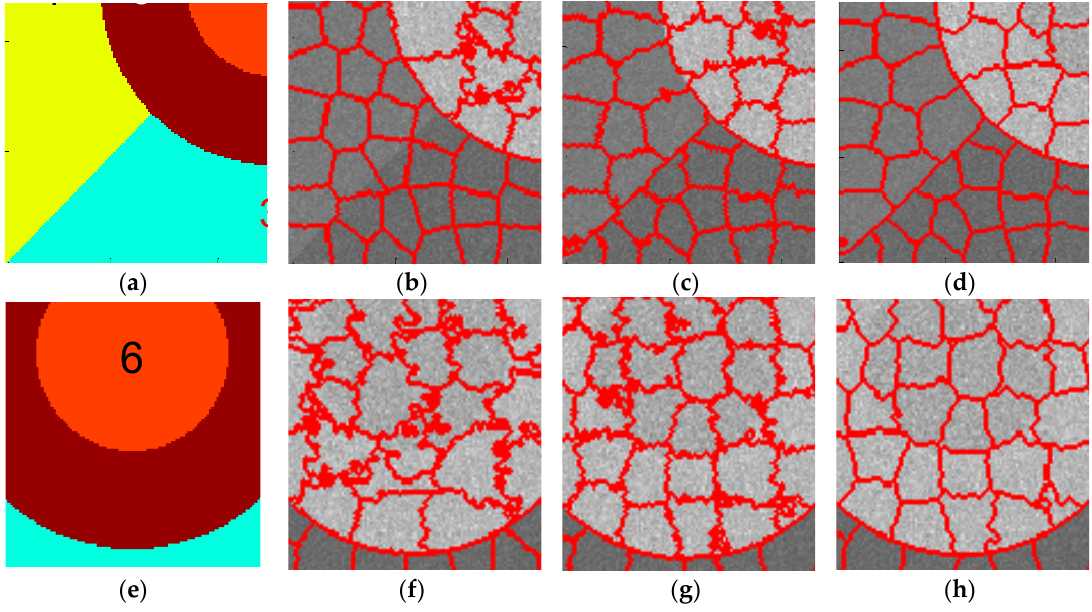
Figure 6. Ground truth of simulated image patches 1 and 2 ( a , e ) and corresponding superpixels provided by standard SLIC ( b , f ), compound method ( c , g ) and proposed algorithm ( d , h ).